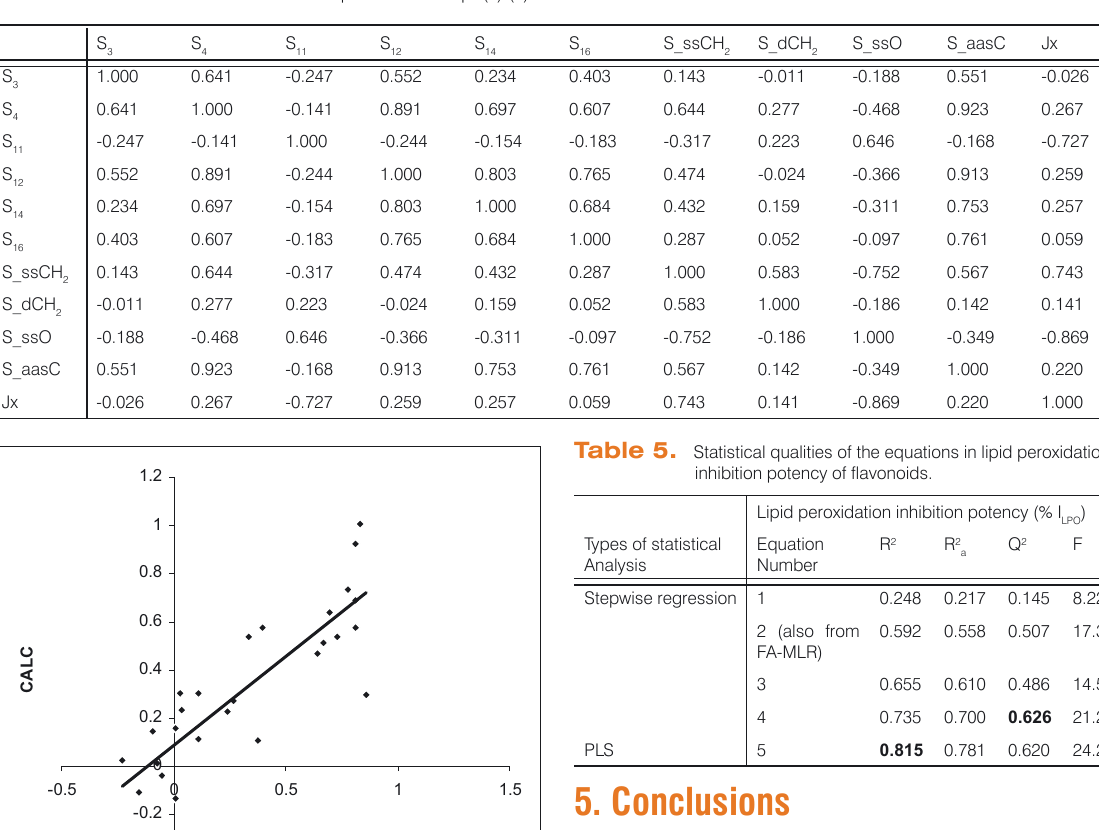
Table 4. Intercorrelation matrix for descriptors used in Eqs. (1)-(5).